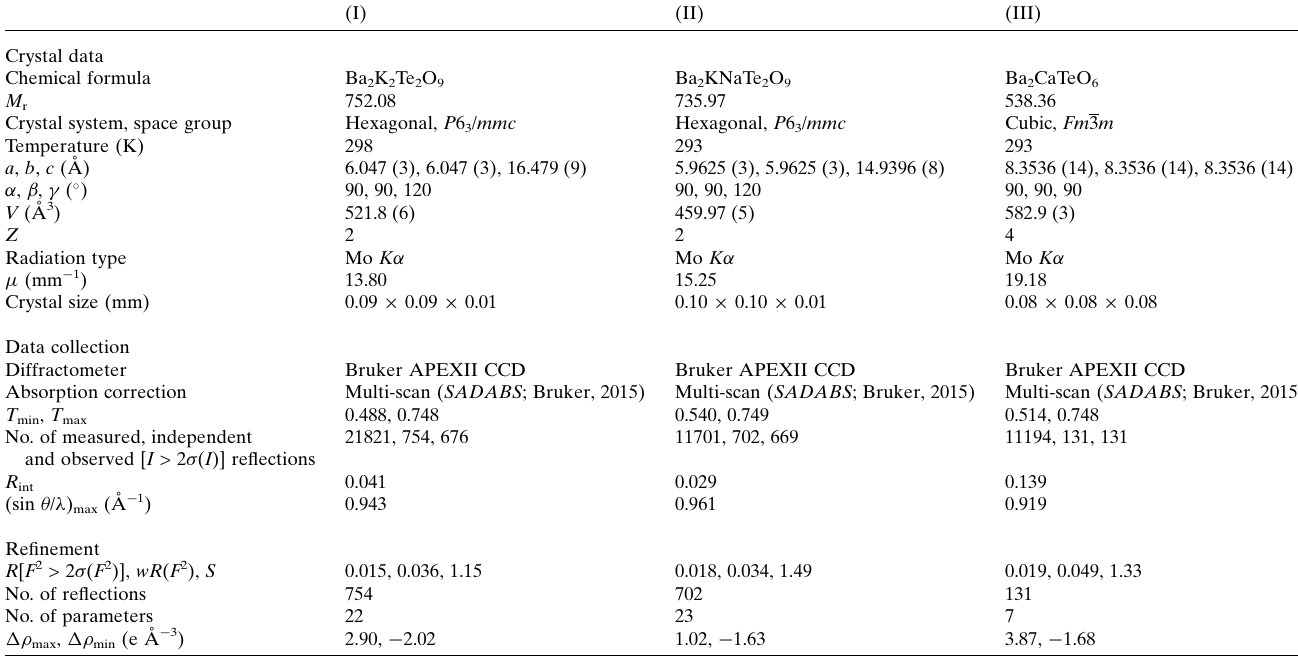
Table 2 Experimental details.